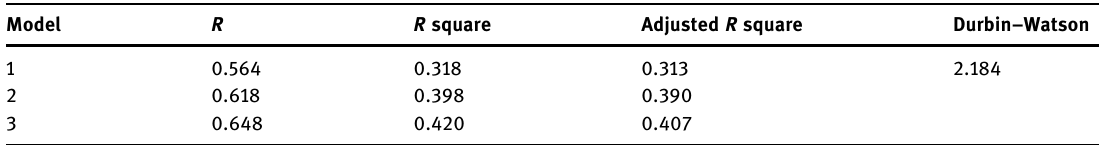
Table 4: Goodness - of - fi t test of brand selection and brand image dimensions